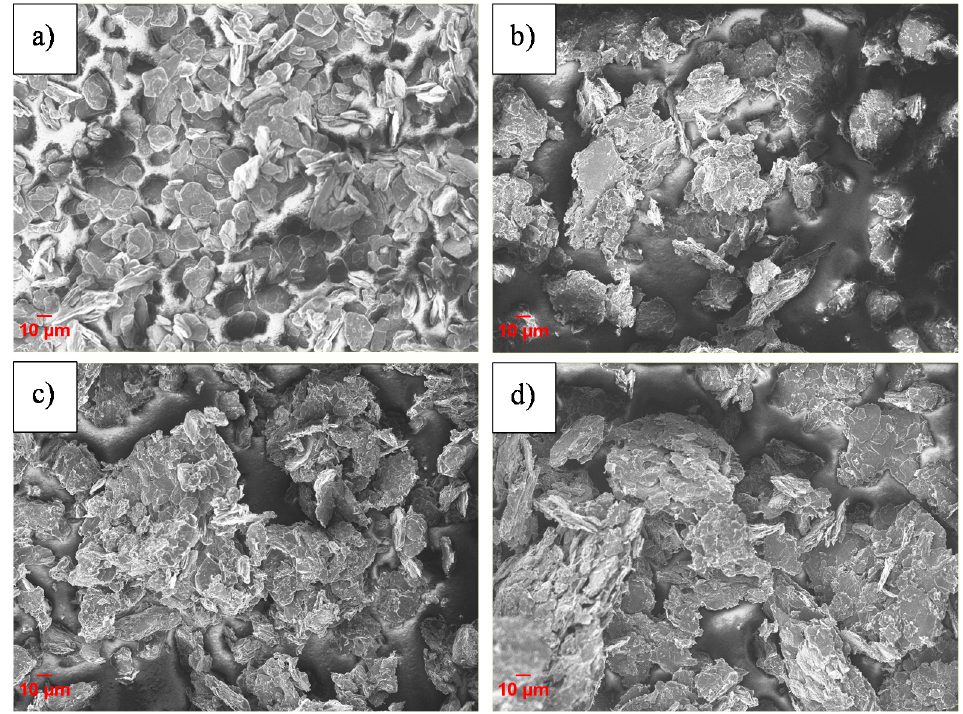
Figure 2. Micrographs of ( a ) pristine and coated graphite materials obtained using ( b ) Method 1, ( c ) Method 2, and ( d ) Method 3. Sucrose was used as the carbon precursor.